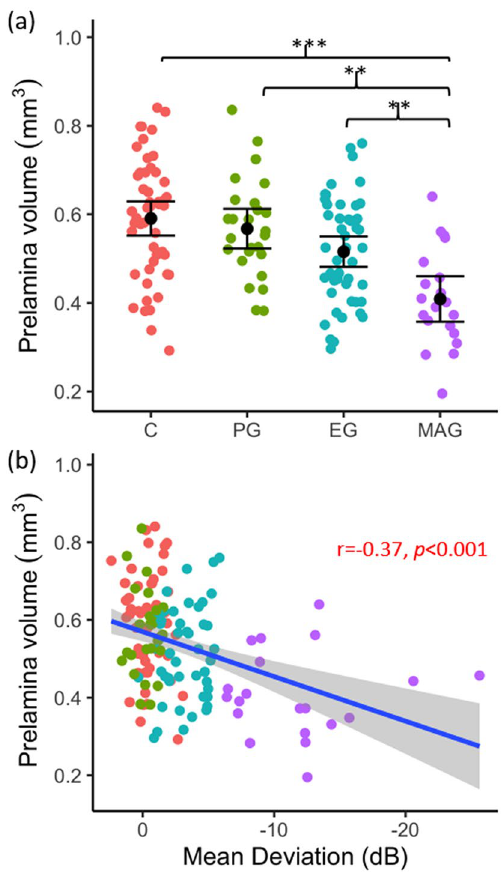
Figure 7. Prelamina volume as a function of glaucoma disease stage ( a ); black point represents mean and error bars indicate 95% confidence intervals, and ( b ) visual field status (VF MD). Blue line represents regression line and grey shading indicates 95% confidence intervals. Red text indicates significant Pearson’s correlation (r) values at p < 0.05. * p < 0.05, ** p < 0.01, *** p <